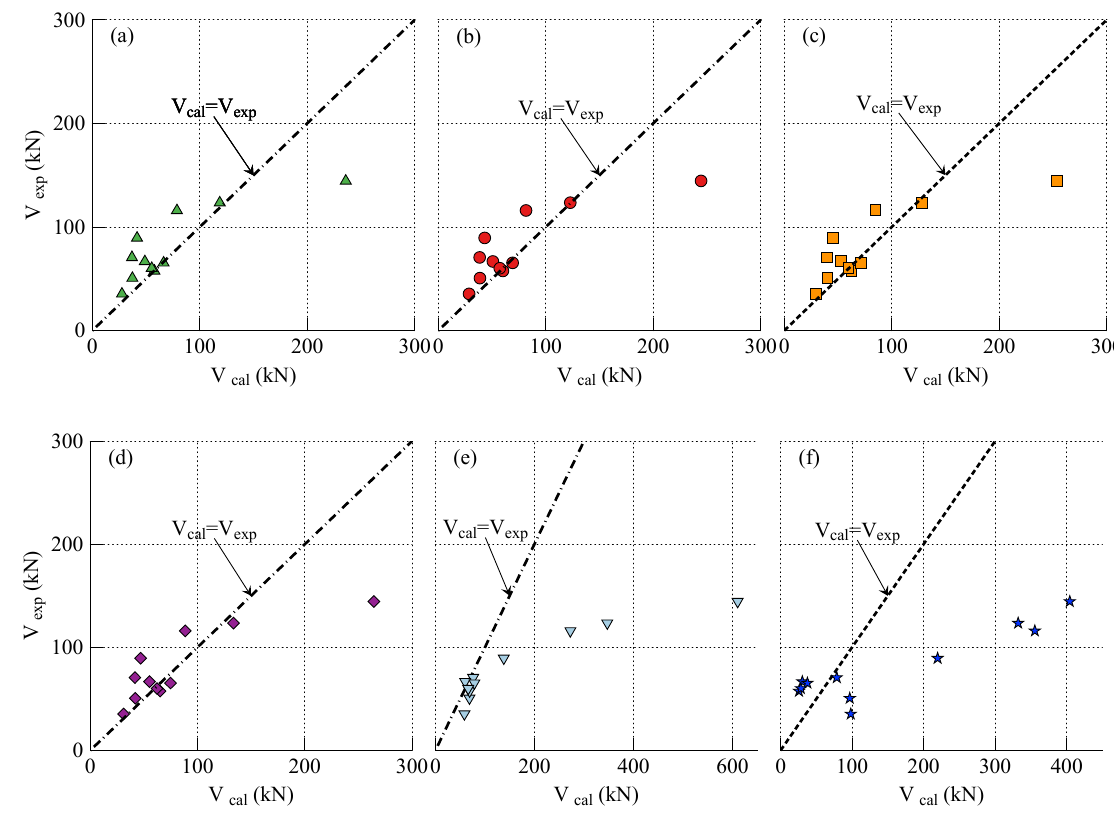
Figure 21. Comparisons between the predictions by the presented model, concrete tooth model, and experimental results of carrying capacity of FRP-strengthened beams, and the specification of amplification coefficient of average crack spacing 𝜁 : ( a ) 𝜁 = 1.35 ; ( b ) 𝜁 = 1.30 ; ( c ) 𝜁 = 1.25 ; ( d ) 𝜁 = 1.20 ; ( e ) without modification; and ( f ) concrete tooth model.